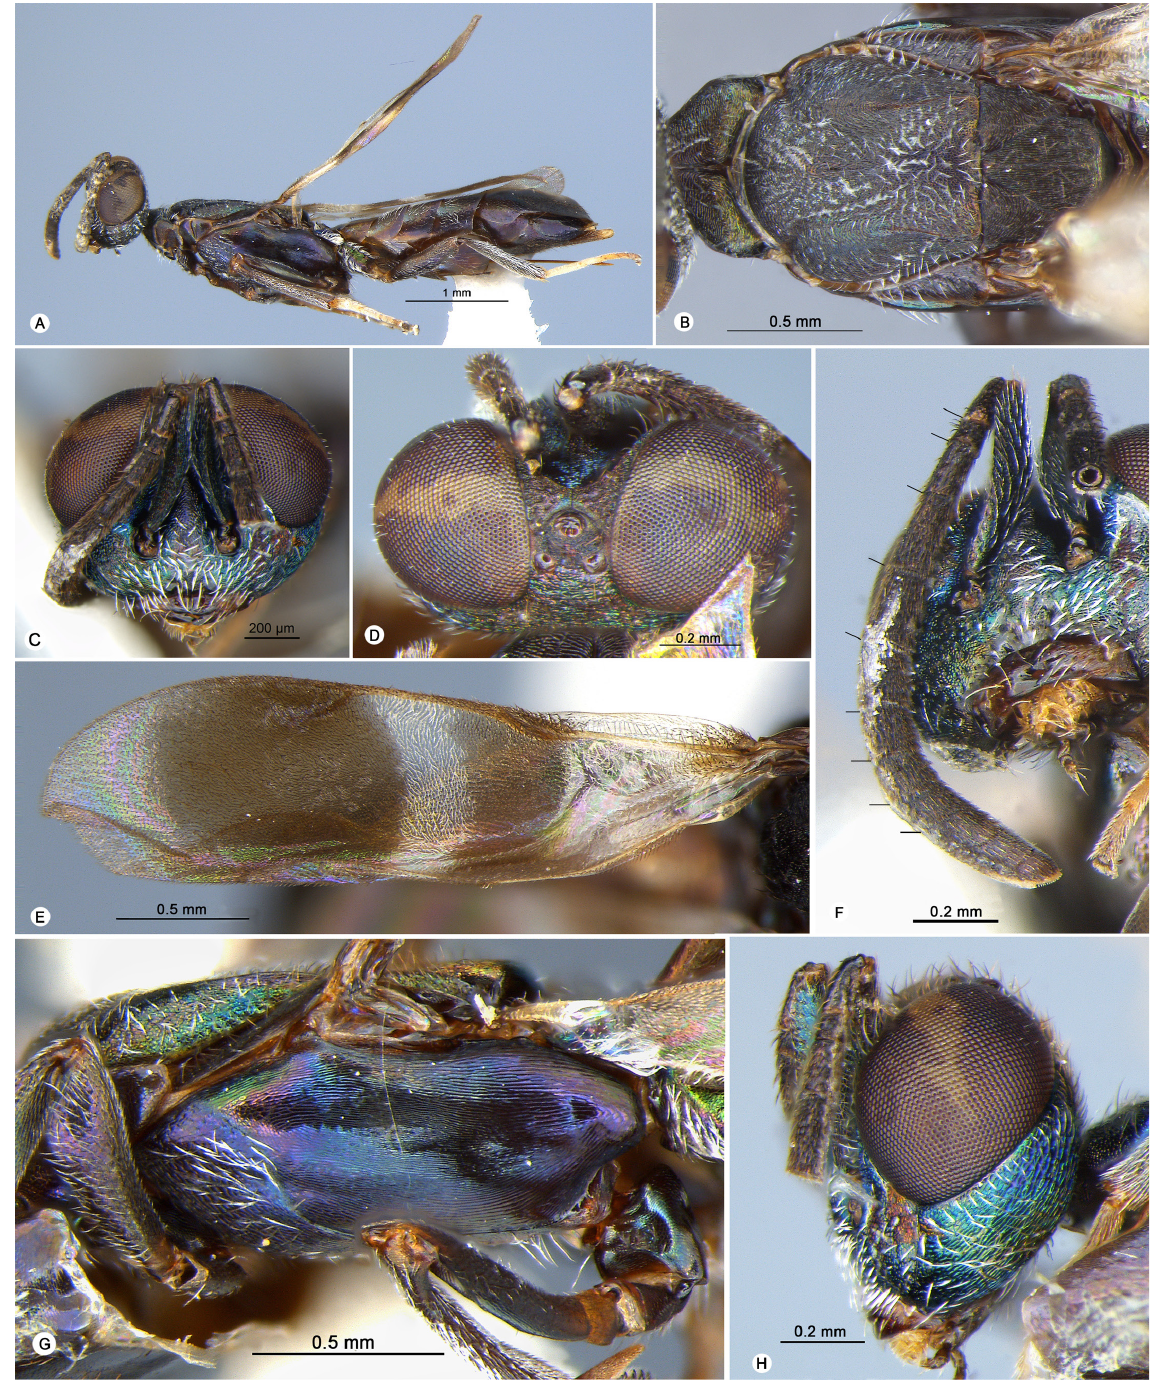
Fig. 4. Zaischnopsis pacis Jiang & Peng sp. nov. A . Body, lateral view. B . Mesosoma, dorsal view. C . Head, front view. D . Head, dorsal view. E . Fore wing. F . Antenna. G . Mesosoma, lateral view. H . Head, lateral